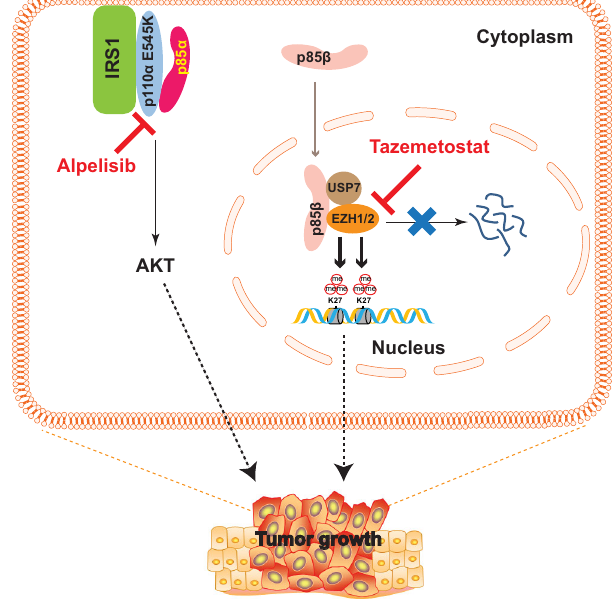
Fig. 8 A model for how PIK3CA helical domain mutations promote oncogenesis. PIK3CA helical domain mutations promote oncogenesis through two independent pathways: (1) p110 α helical domain mutant protein directly interacts with IRS1 to activate the canonical PDK1-AKT pathway 12 ; and (2) p85 β translocates into the nucleus, stabilizes EZH1/2 by recruiting deubiquitinase USP7, and enhances H3K27 trimethylation. Simultaneously targeting both pathways with Alpelisib, a p110 α inhibitor, and Tazemetostat, an EZH2 inhibitor, induces regression of tumors harboring a PIK3CA helical domain